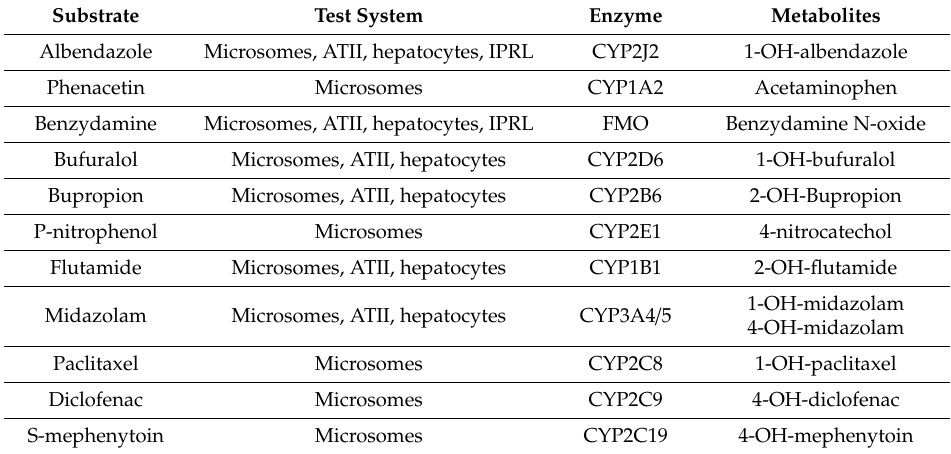
Table 1. List of substrates and the in vitro and / or ex vivo systems used to study metabolism in the present study. Legend: ATII, alveolar type II; FMO, flavin-containing monooxygenases; IPRL, isolated perfused rat